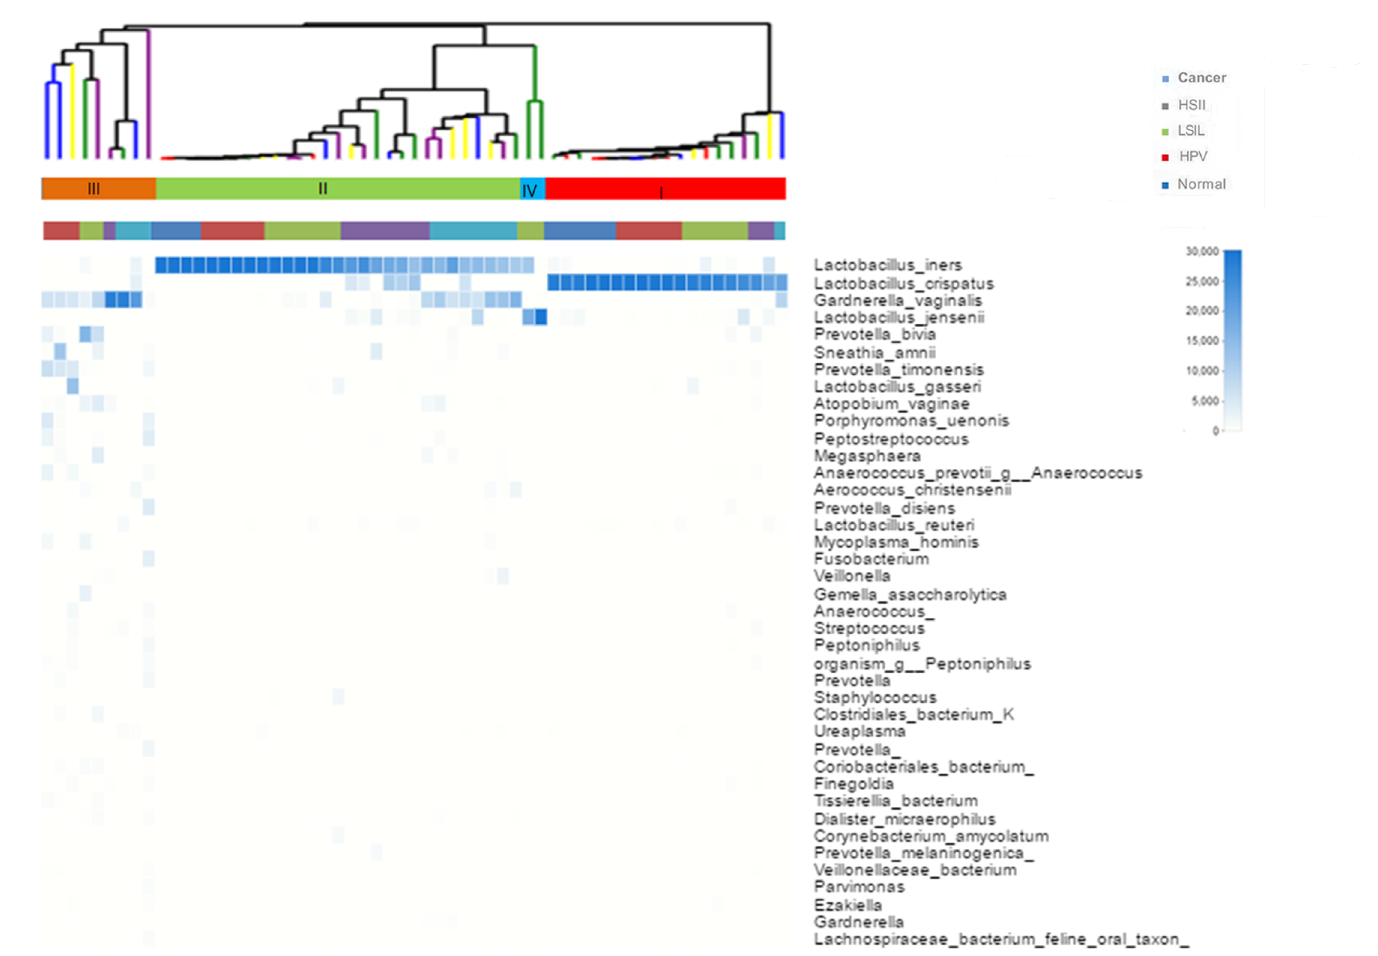
Figure 2 - Heat map analysis, each vertical line represents a sample. Relative abundance is shown in blue and white: blue indicates a high proportion, and white indicates a low proportion. Five groups (normal, HPV, LSIL, HSIL, cancer) were distributed in different CSTs with different colors.